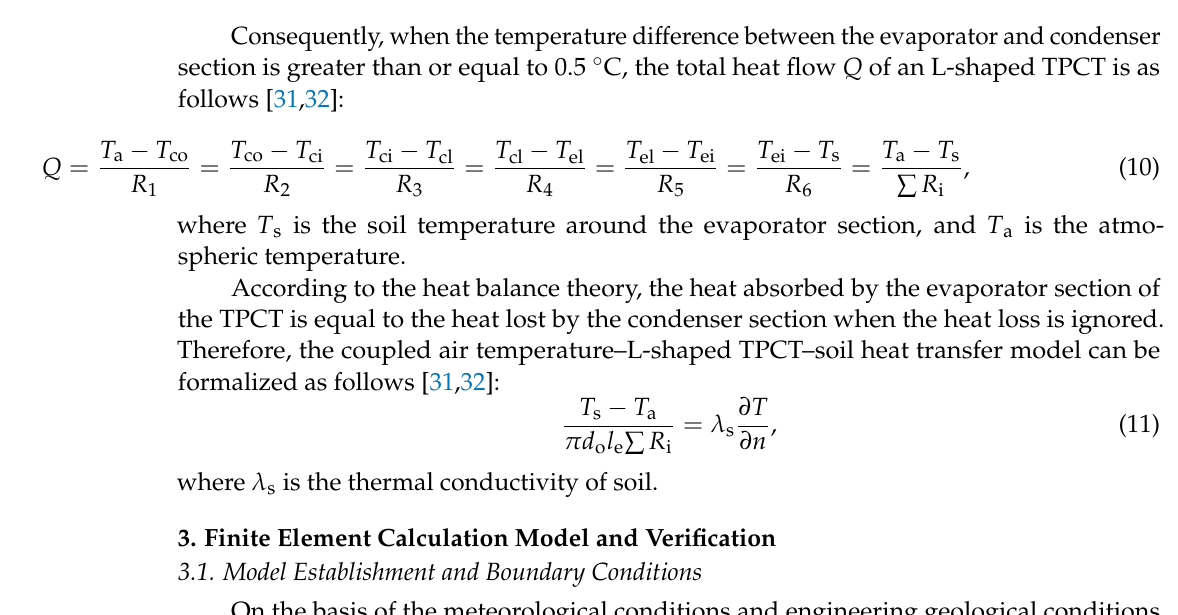
Figure 2. Heat transfer coefficient rate at different inclination angles of the evaporator.